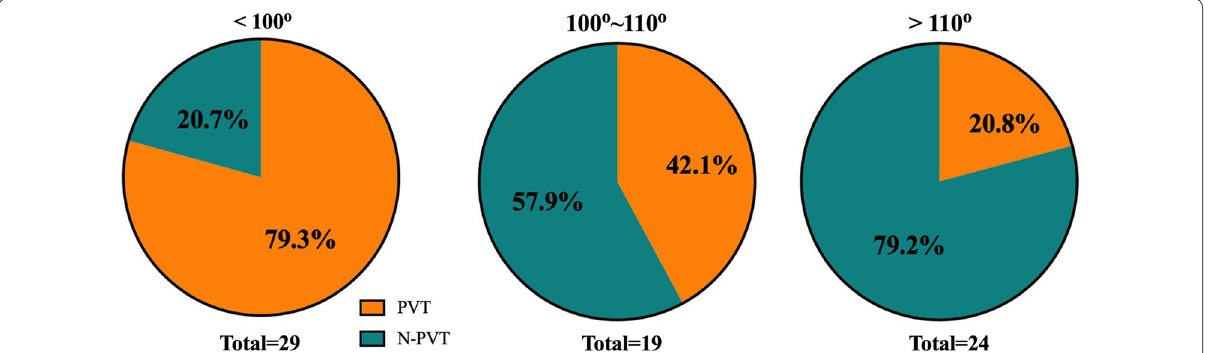
Fig. 3 The prevalence of PVT according to degree of angulations of SMV and